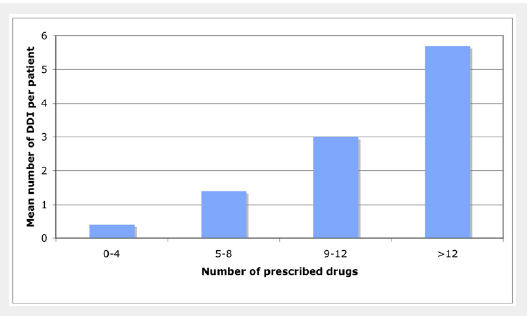
Correlation of number of prescribed drugs and number of drug-drug